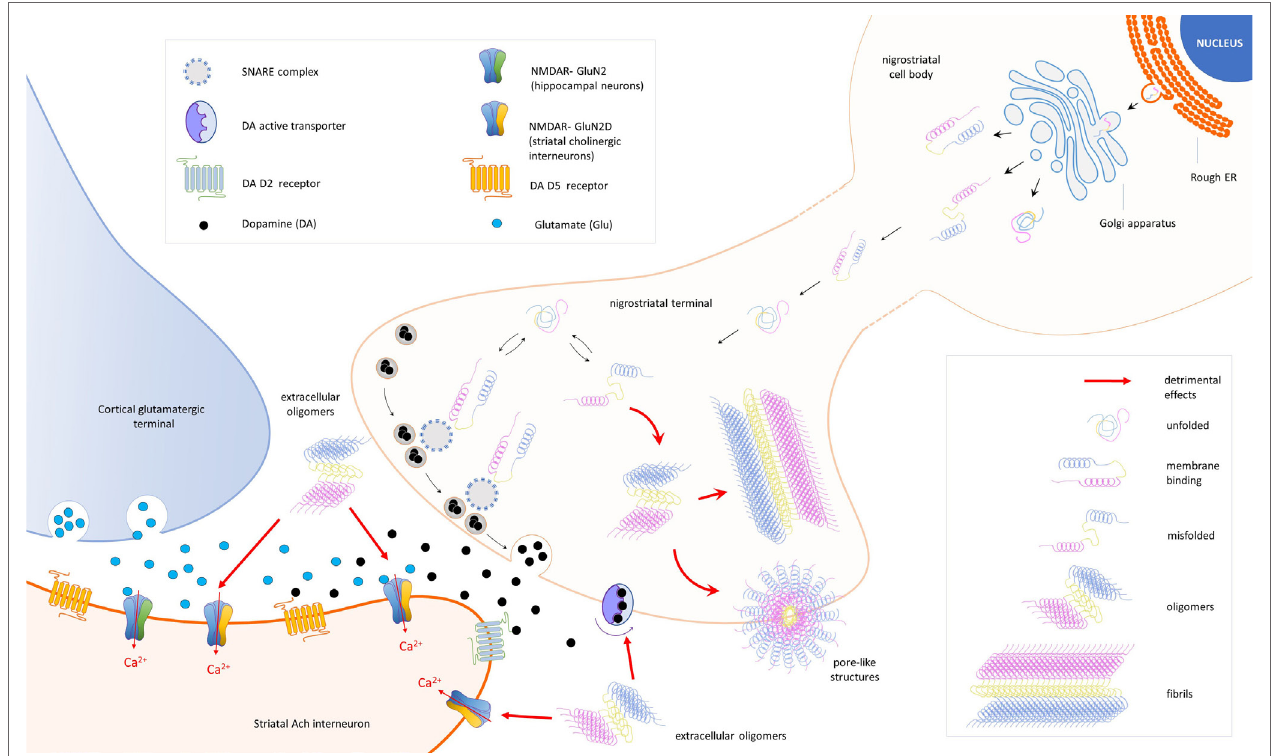
FiGURe 1 | Schematic representation of the cellular and synaptic detrimental actions mediated by different forms of the protein alpha-synuclein ( α -syn). In nigral neurons, endoplasmic reticulum (rough ER), SNCA transcripts are translated into native α -syn proteins, which are assembled in the Golgi apparatus and released in different conformations. Due to its auto-chaperone activity, α -syn exists in a dynamic balance between monomeric unfolded and amphipathic alpha-helix (membrane binding) state, adopting a range of conformations depending on the environment and binding partners. During the assembly process, misfolding proteins might be also produced (misfolded) and escape detection and clearance by intracellular quality control systems. After synapse maturation, α -syn migrates to nerve terminals and interacts with intracellular proteins [SNAP REceptor (SNARE) complex] and the dopamine (DA) active trasporter to ensure a correct control of neurotransmission. Misfolded α -syn may combine into oligomers that, under specific stimulations, form transmembrane pore-like structures able to alter membrane conductances. Overexpression of α -syn exacerbates pathological events and culminates with the formation of fibrillar aggregates (fibrils), a major component of Lewy bodies. Extracellular α -syn oligomers interfere with the expression of long-term potentiation, a form of synaptic plasticity mediated by N -methyl- d -aspartate receptors (NMDAR) in striatal cholinergic interneurons. A direct interaction between α -syn and the GluN2D subunit has been demonstrated in three different models of experimental